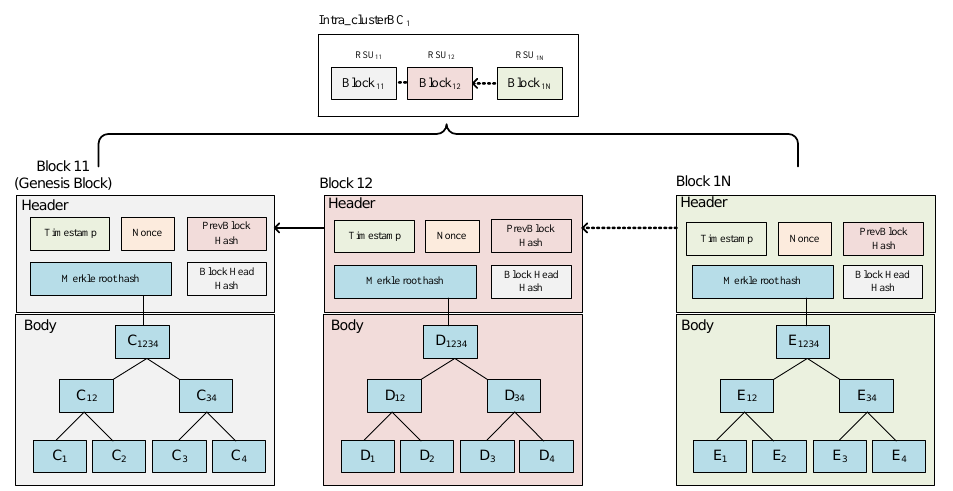
Figure 7. The detailed structure of the intra_clusterBC.